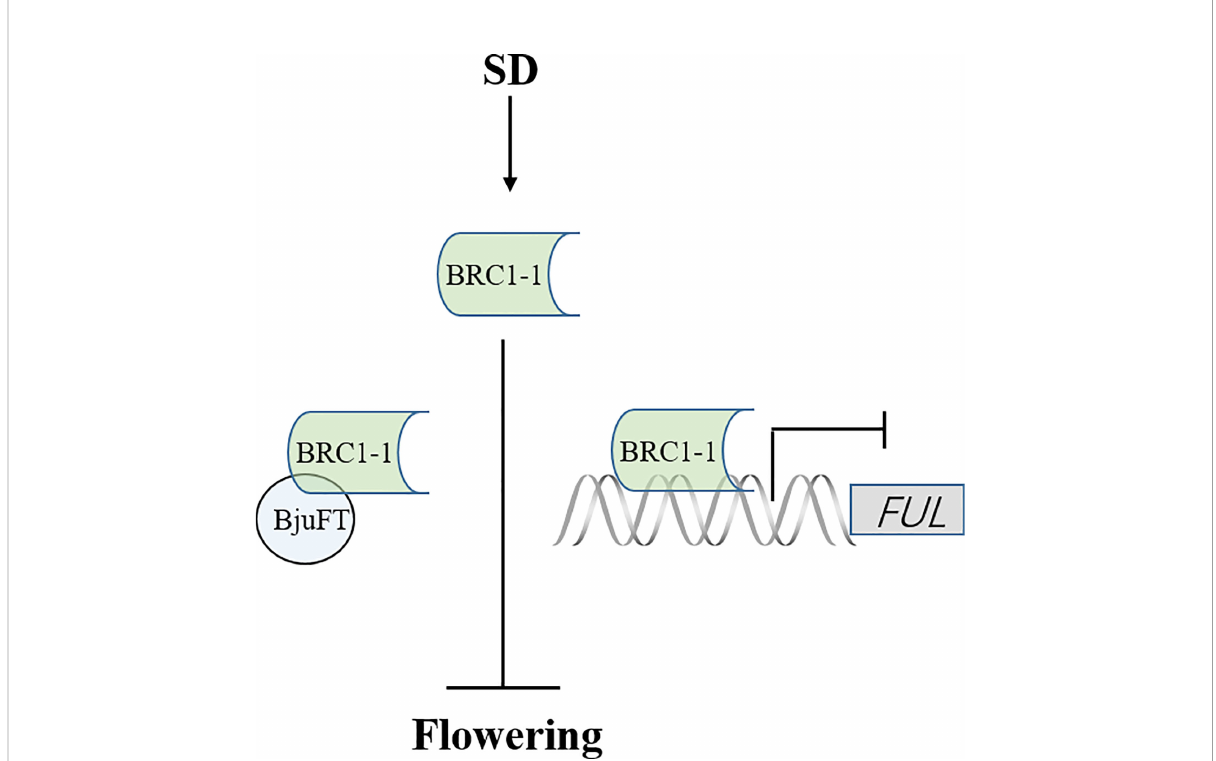
FIGURE 8 A proposed model of BjuBRC1-1 to regulate fl owering. FT, FLOWERING LOCUS T; FUL, FRUITFULL; arrow, enhanced expression; horizontal line, inhibited